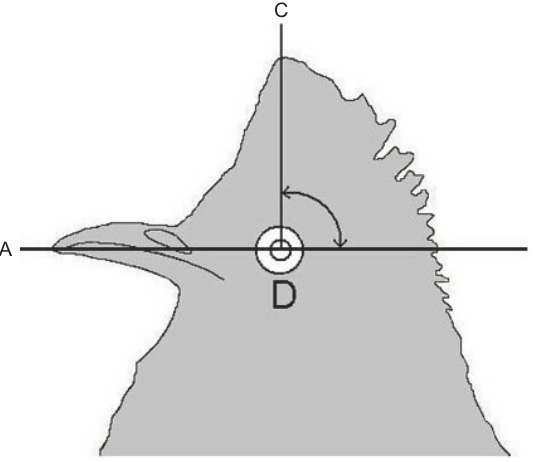
Figure 1. Measurement of elevation of crest in Red-vented